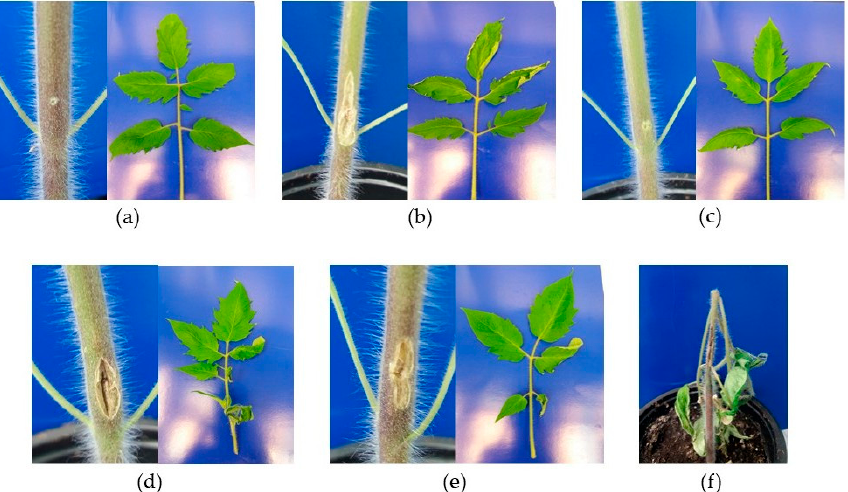
Figure 1. Virulence assay of Chilean Cmm strains in tomato seedlings cv. San Pedro. Disease symp- toms of tomato seedlings 21 days after inoculation. Different levels of damage were observed in stems (canker in site of inoculation) and leaves (wilting) in ( a ) negative control and strains ( b ) VQ28, ( c ) VQ143, ( d ) MSF322, ( e ) OP3, and ( f ) VL527.